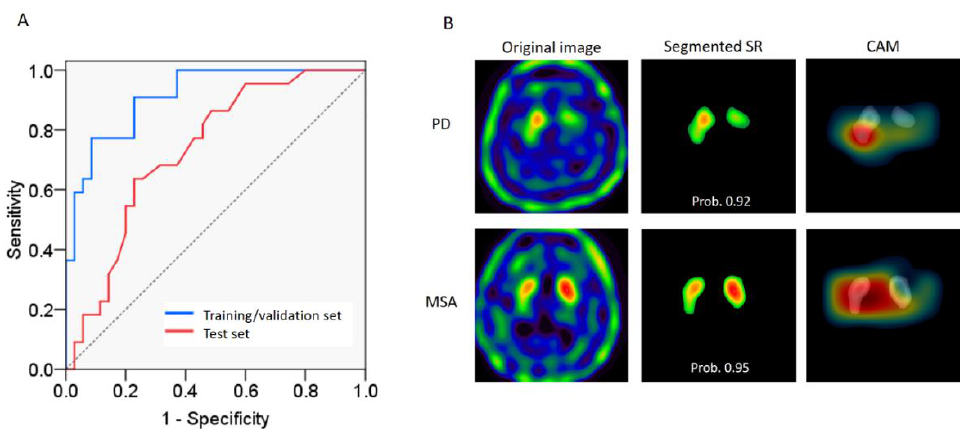
Figure 4 . Classification of the test dataset using the ANN classifier. ( A ) The area under the receiver operating characteristic curve (AUROC) was 0.94 in the training/validation dataset (blue line) and 0.76 in the test dataset (red line). ( B ) Examples of classification using the ANN classifier for each group. Upper row is an example of PD and the lower row non-PDs. Left column: the images before scalp-mask and segmentation. Middle column: the images of segmented SR using the active contour model. Right column: the CAM represented with a heat map. The computer-vision weighted more on areas with a warmer color when examining the images. Overlaying on SR images showed that the computer focused most on the putamen. This PD subject was a 58-year-old male with symptoms of resting tremors in his right hand for 2 years and H&Y stage 2 when DAT-SPECT was obtained. Another example case of multiple system atrophy was a 69-year-old male who had symptoms of urinary incontinence, orthostatic hypotension, and cerebellar features of dysmetria and parkinsonism. The disease duration before DAT-SPECT was obtained was 2 years. Prob., probability of class.